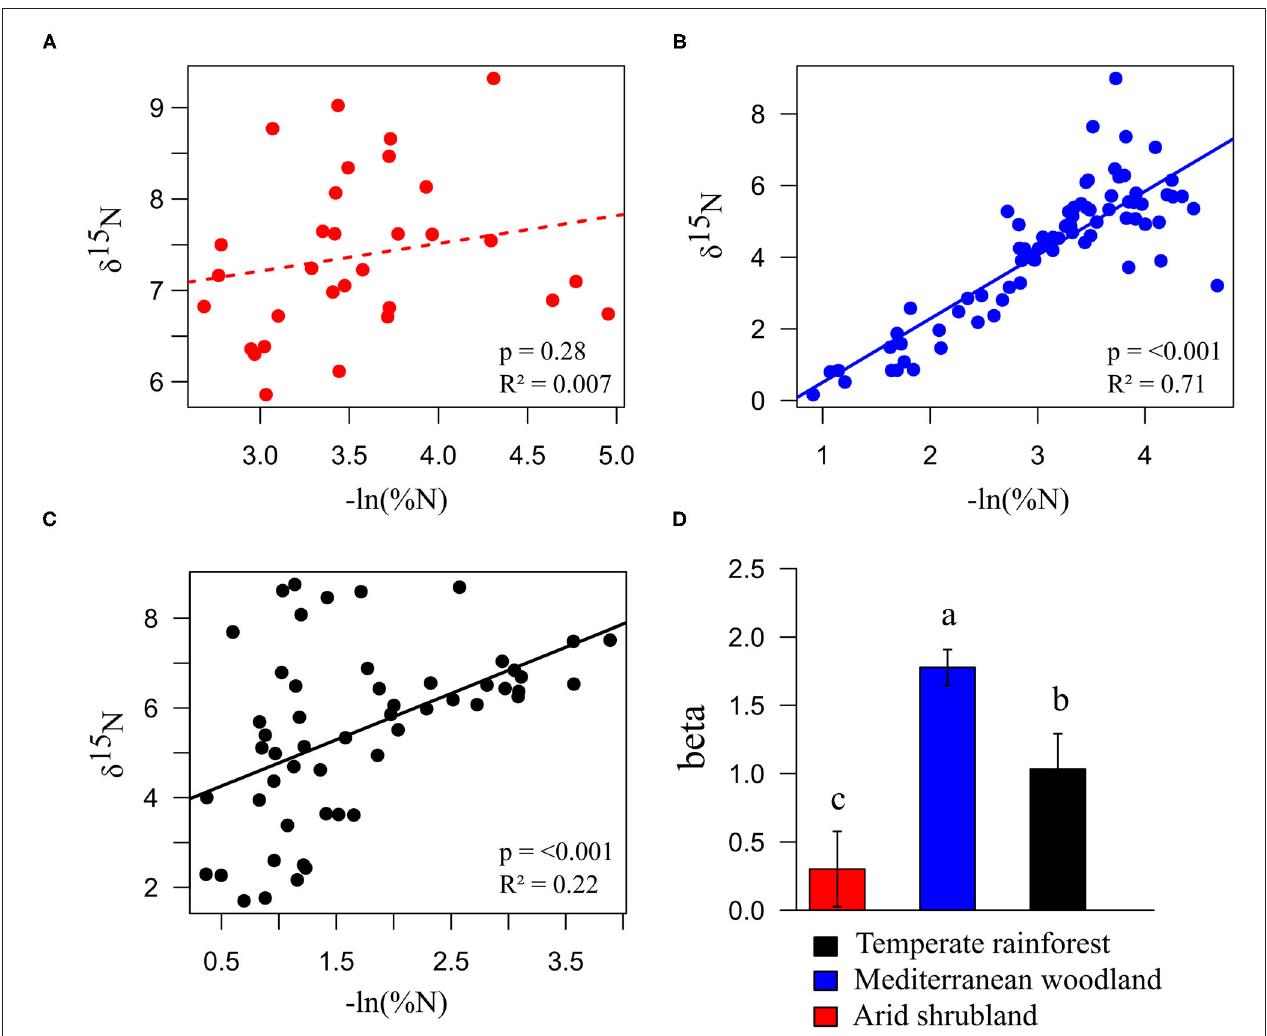
FIGURE 2 | Estimation of N turnover in soil based on the regressions of δ 15 N vs. -ln(%N) for the arid shrubland (A) , Mediterranean woodland (B) , and temperate rainforest (C) as well as the regression slopes (beta) presented with the regression standard errors (D) . The dashed line represents non-significant regression. Lower case letters indicate significant differences between regression